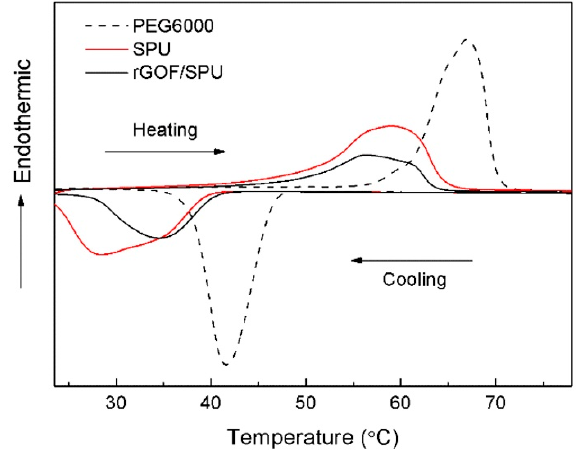
Figure 4. Differential scanning calorimeter (DSC) curves of PEG6000, SPU, and rGOF/SPU.